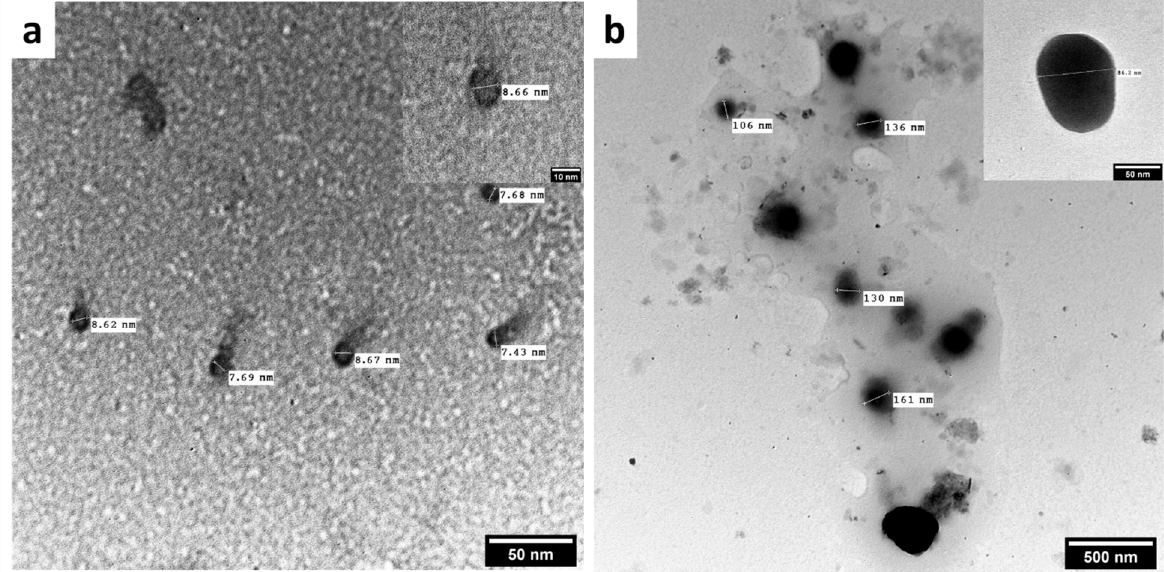
Figure 1. TEM image of ( a ) microwave-synthesized C-dots, ( b ) hydrothermally synthesized C-dots. In each inset, a single particle can be seen.